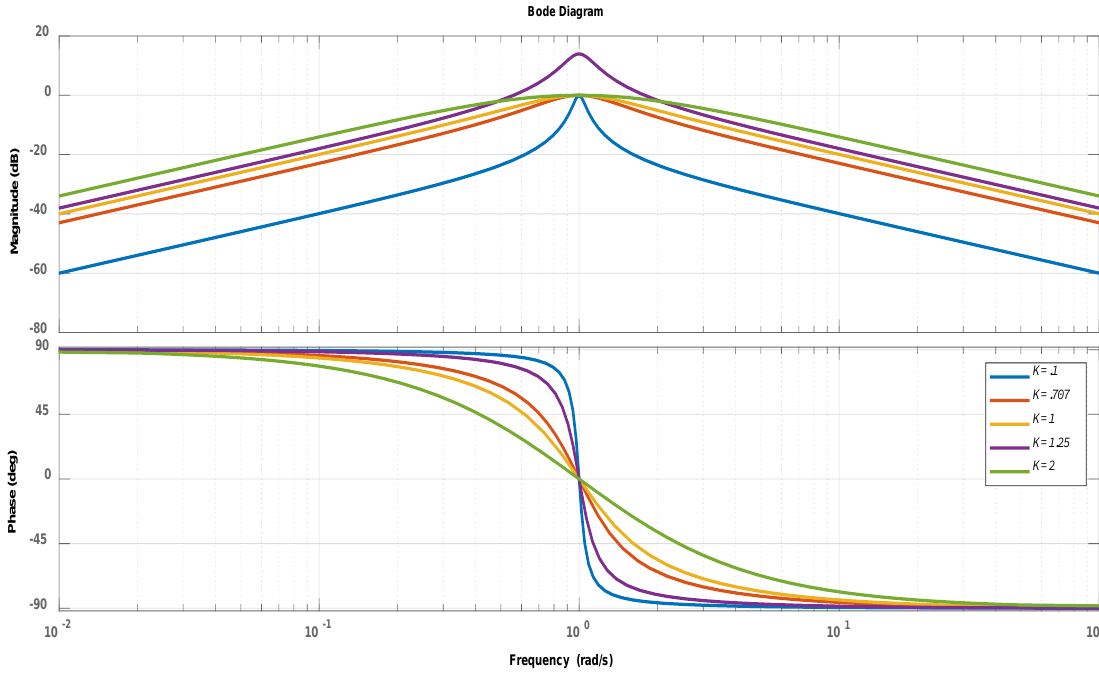
Figure 11. Frequency response plot of v α ( s